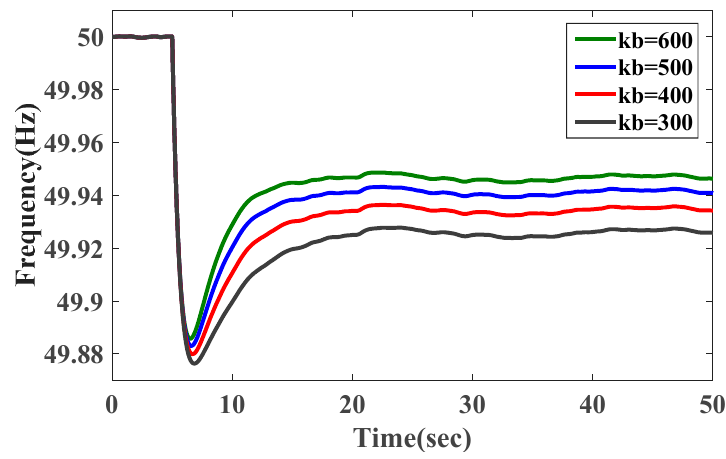
Figure 15. The impact of parameter k b on frequency dynamic response.